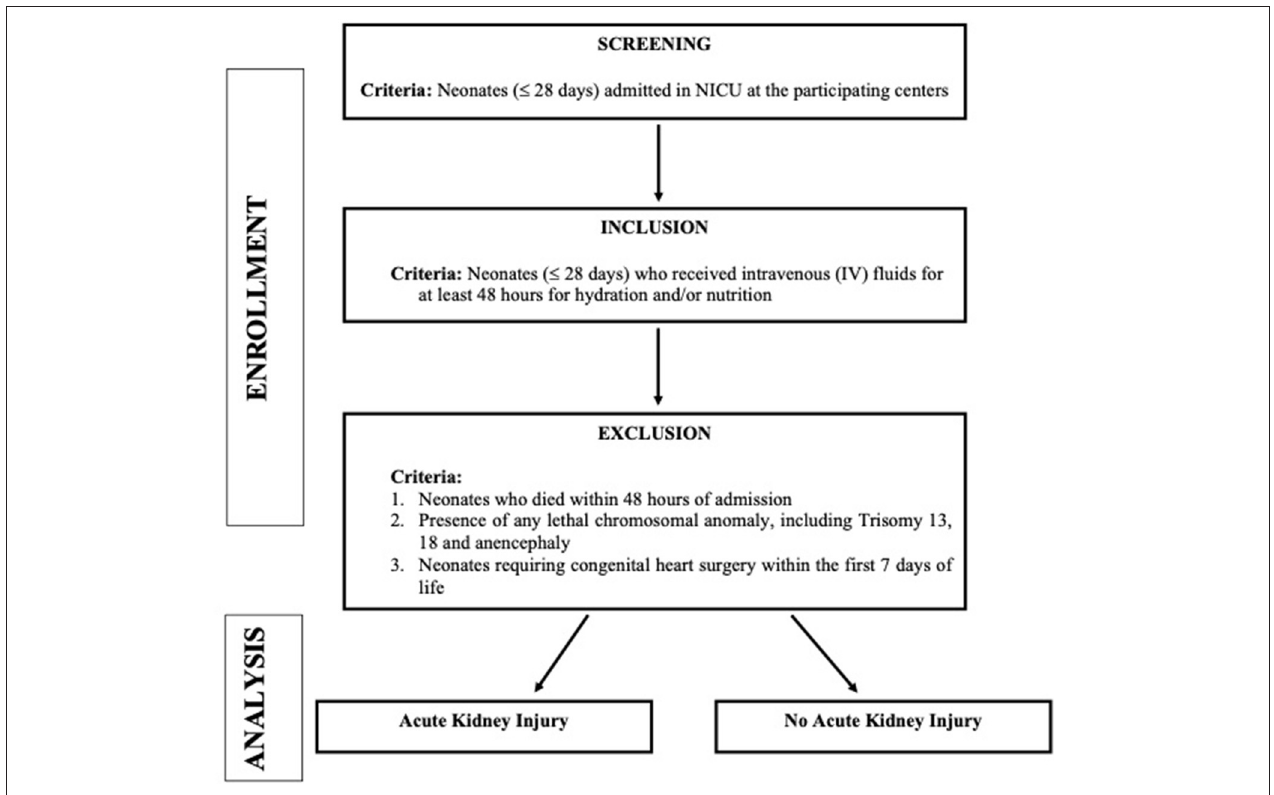
FIGURE 1 | Plan of the study.